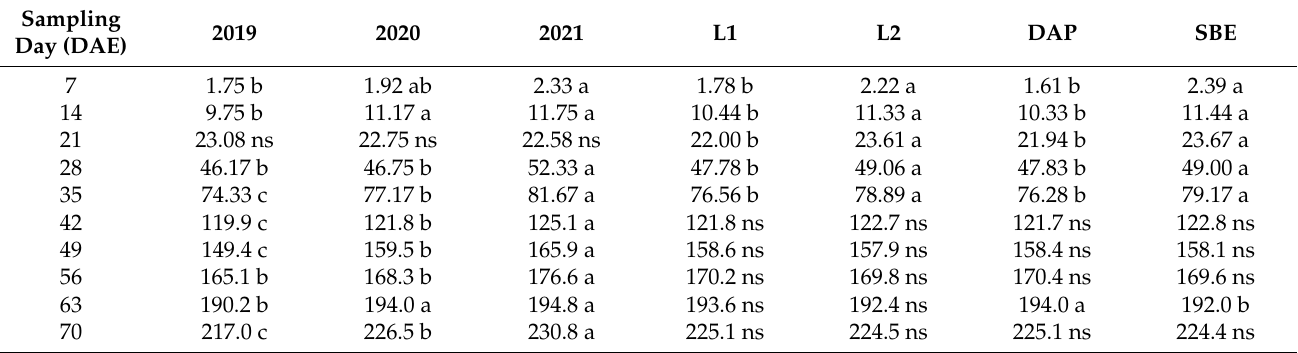
Table 4. Dynamics (from 7 to 70 DAE) of plant height (mm) for each growing season, location, and applied